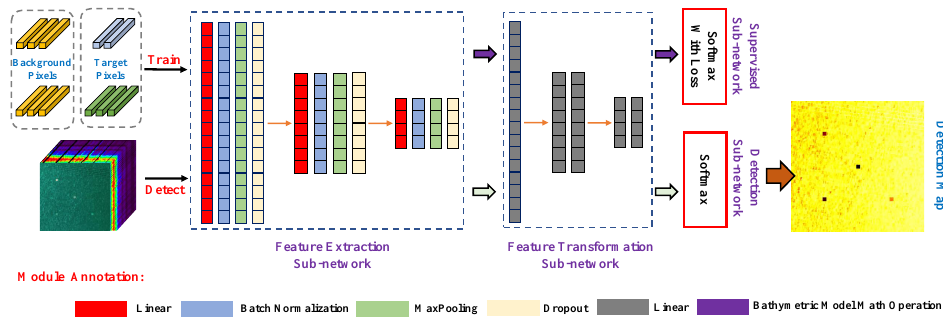
Figure 5. The constituents of the target detection network. Feature extraction sub-network. The feature extraction is a stack of cascade DNN blocks with different convolution steps. Here, in each block, there exists a convolution layer, pooling layer, batch normalization, dropout, and nonlinear activation. Similar with the first block in the encoder part, we employ this sub-network to refine the spectral information provided with input HSI. Besides, it can also assist to reduce the network parameters, adapt the spectral variability, and boost the generalization ability for the target detection network. Feature transformation sub-network. The feature transformation sub-network is made up of some fully connected layers containing different amounts of neurons, which is utilized to predict the class probability for each pixel. This sub-network firstly flattens the spectral features derived from the last sub-network for dimensionality reduction. Then, it transforms the flattened feature vector into a two-dimensional prediction vector. To make the sub-network more capable and stable, the nonlinear activation function and dropout trick are also imposed between different fully connected layer